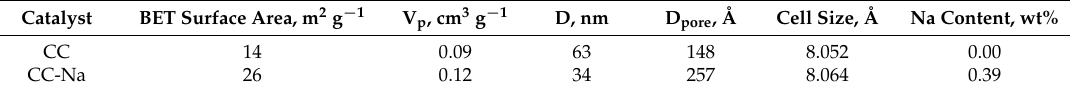
Table 1. Results from physico-chemical